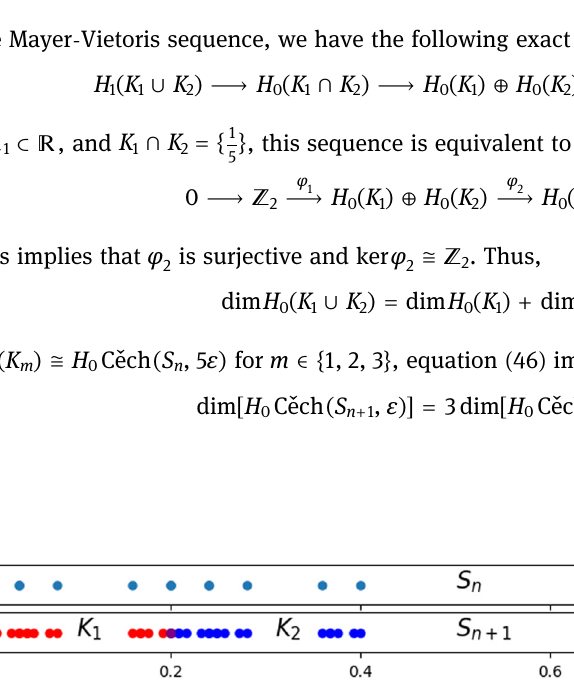
Figure 3: The three subcomplexes in the modi fi ed 1/5 Cantor set for = n 3